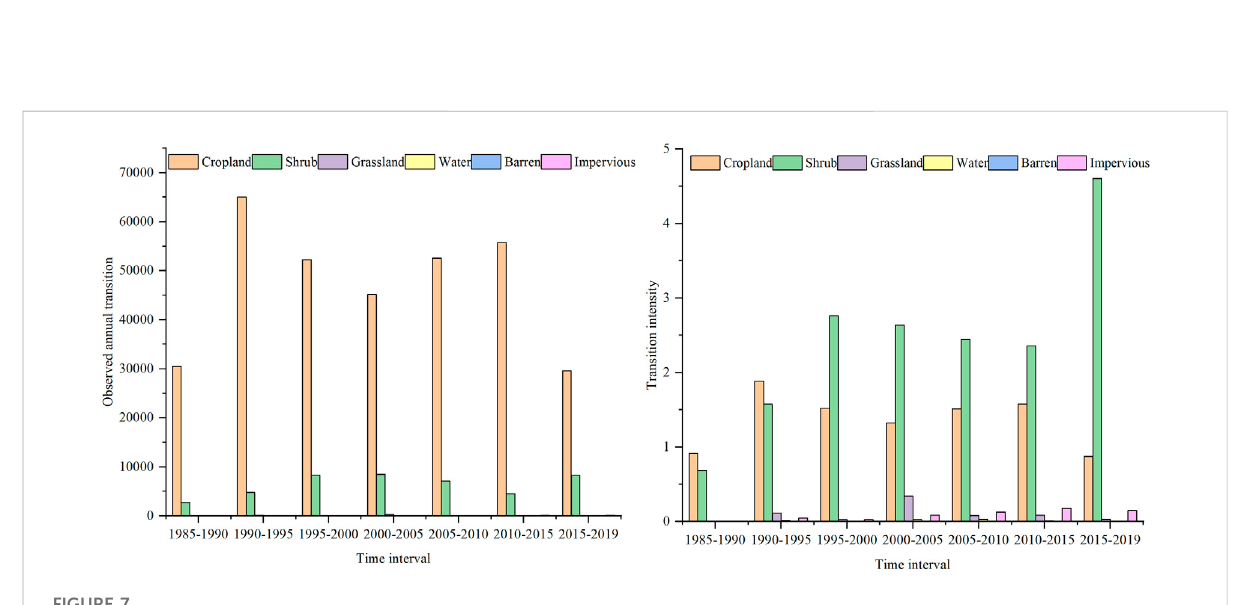
FIGURE 7 Transition from forest land to other land use types in the transition